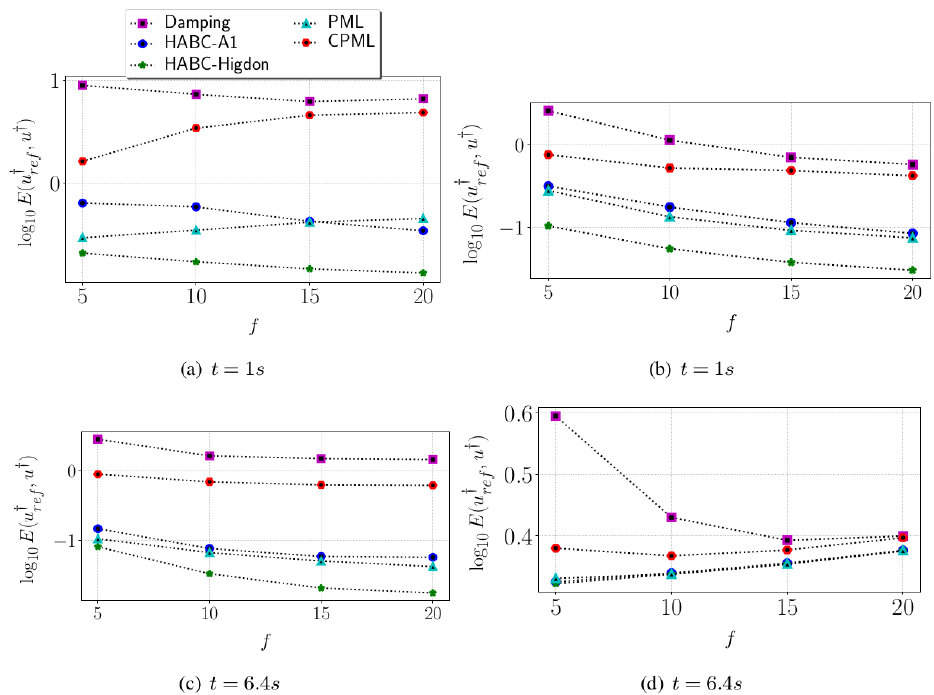
Figure 11. Error curves of the adjoint solution u † with respect to the peak of the frequency. The tests consider the wave solutions for the velocity models, including (a) the circle, (b) a heterogeneous model built with horizontal layers, (c) part of the Marmousi model, and (d) the 2D SEG/EAGE salt model.